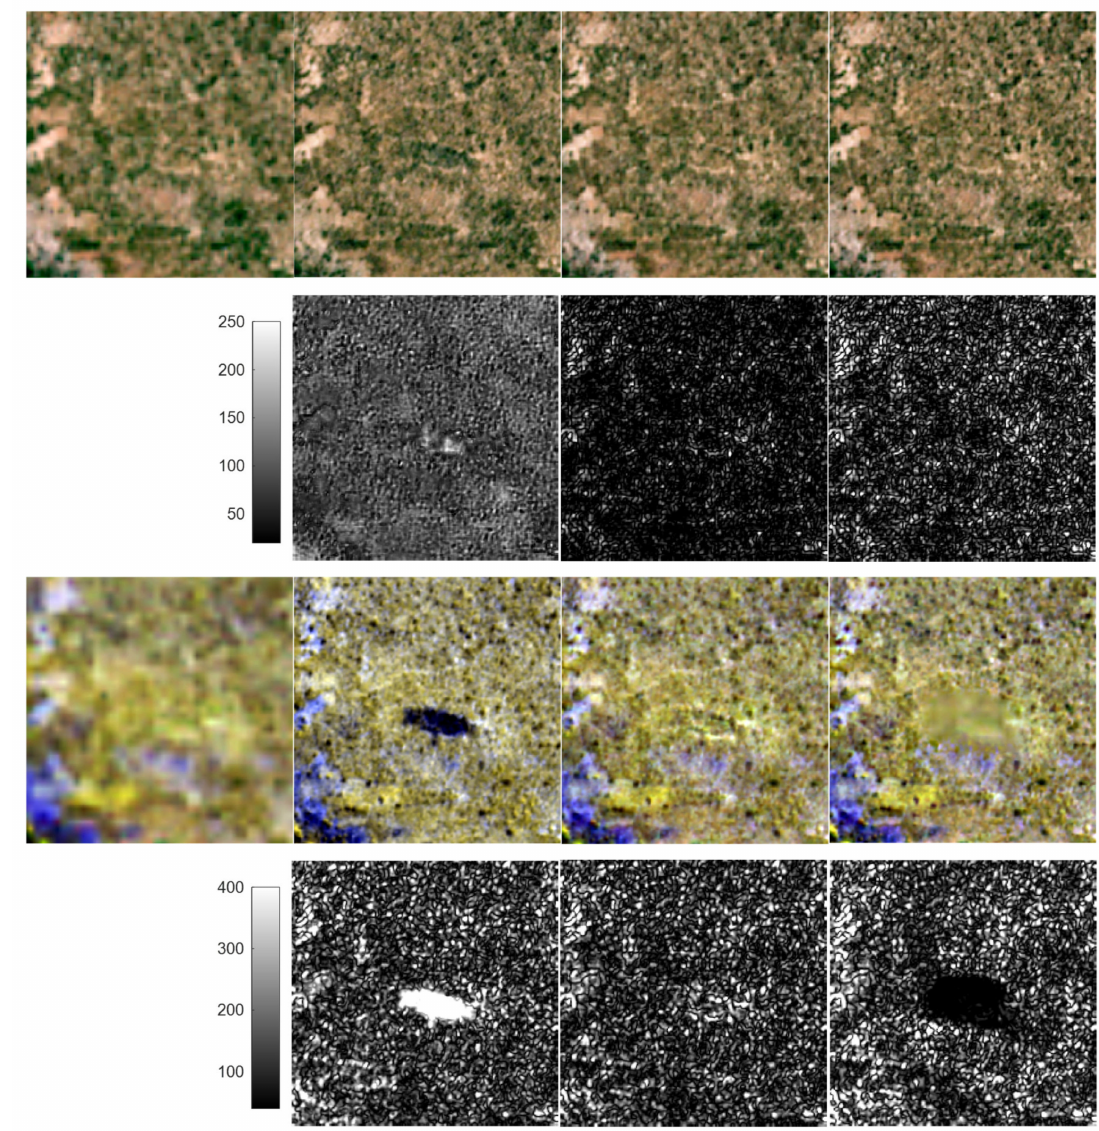
Figure 8. Study site 2 spatial subset (240 × 240 3.333 m pixels, 0.8 × 0.8 km), top row: true color (red, green, and blue) surface reflectance, third row: false color (NIR 855–875 nm, red-edge 773–793 nm, and SWIR 1565–1655 nm) surface reflectance. The columns show from left to right: Sentinel-2 surface reflectance bilinear resampled to 3.333 m, Planetscope-0 3.333 m surface reflectance, HPM sharpened 3.333 m surface reflectance, and M3 sharpened 3.333 m surface reflectance. The second and fourth rows (greyscale figures) show the root mean square di ff erence (RMSD = between the Sentinel-2 bilinear resampled reflectance ( ρ λ , bilinear , left column) and the Planetscope-0 3.333 m, HPM, and M3 sharpened reflectance ( ρ λ , x , shown in the three right columns). RMSD values are scaled in reflectance units (0–1) multiplied by